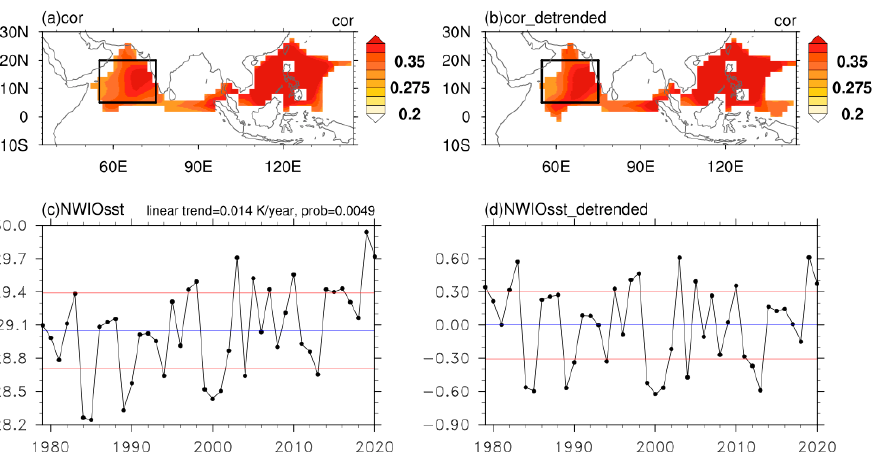
Figure 2. Relation between June EKE and SST: ( a ) correlation between time series of EOF1 and SST in June; only values significant at the 0.05 significance level or better are presented; ( b ) similar to ( a ), showing the detrended signal; and ( c , d ) northwest Indian Ocean SST and its detrended values, respectively; blue line indicates the average and red lines indicate ±0.82 (standard deviation).